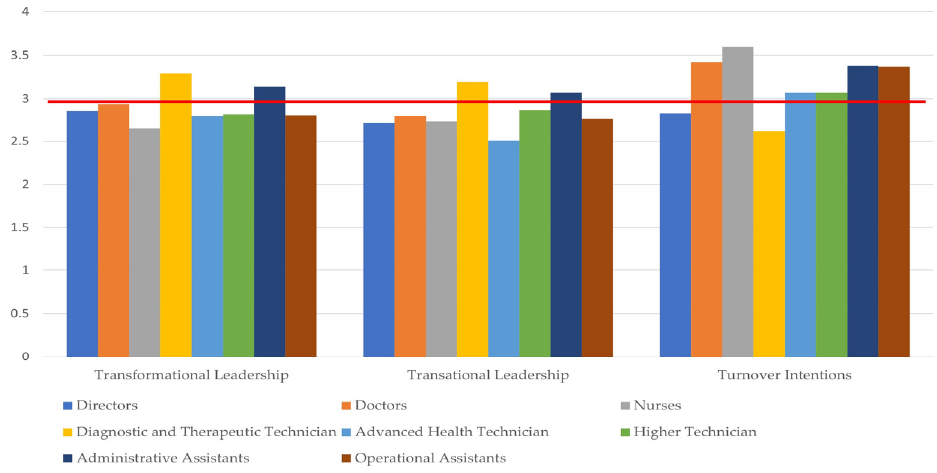
Figure 3. Leadership and Turnover Intentions according to professional Category.